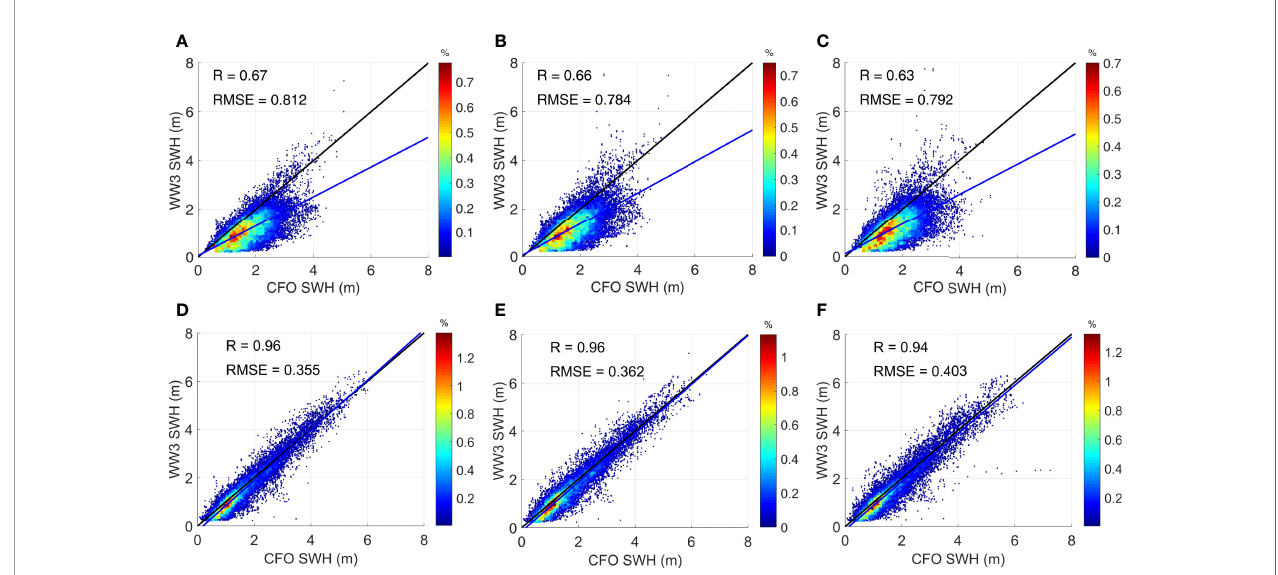
FIGURE 11 | Scatter plot of signi fi cant wave height (SWH) from observations from CFOSAT (unit: m) and (A, D) 0 – 24 h, (B, E) 49 – 72 h, and (C, F) 97 – 120 h forecasts without swell propagating from boundary (NOBC_WW3) for the (A – C) EIO and (D – F) WIO. R is the correlation coef fi cient, and RMSE is the root mean square error.